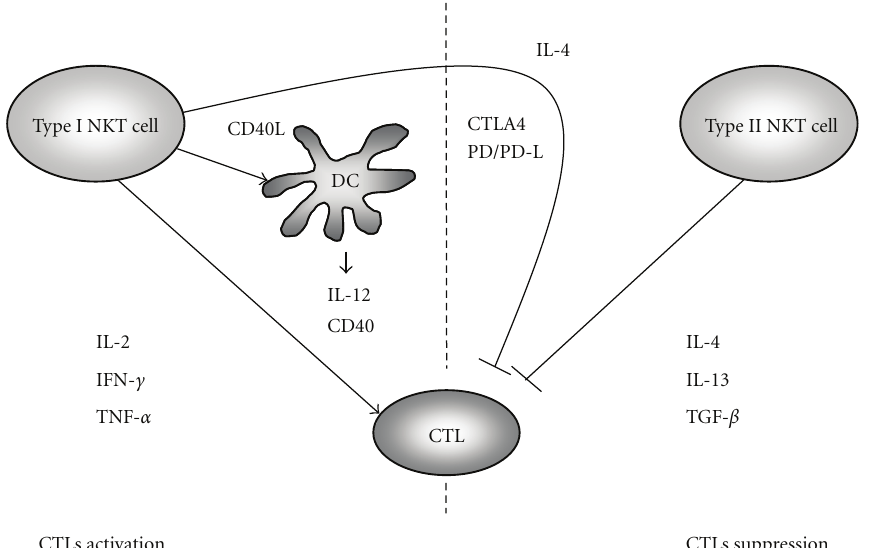
Figure 1: Cellular and molecular mechanisms of CTLs responses mediated by type I and type II NKT cells. Activated type I NKT cells have two distinct e ff ects that regulate CTL function. CTLs are activated by type I NKT cells via cytokines (IL-2, IL-12, IFN- γ , and TNF- α ) and costimulatory molecules (CD40L and CD28). In contrast, increased expression of Th2 cytokines (IL-4) and other costimulatory molecules (CTLA-4 and PD-L) inhibits CTL production or activation. Activated type II NKT cells suppress CTL activity via cytokines (IL-4, IL-13, and TGF- β